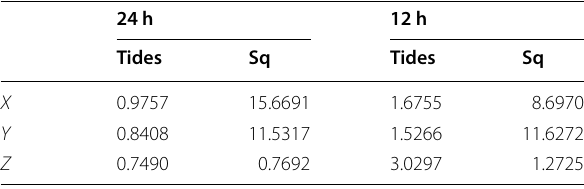
Table 4 Results for geomagnetic observatory CZT (Crozet Archipelago; South Indian Ocean)